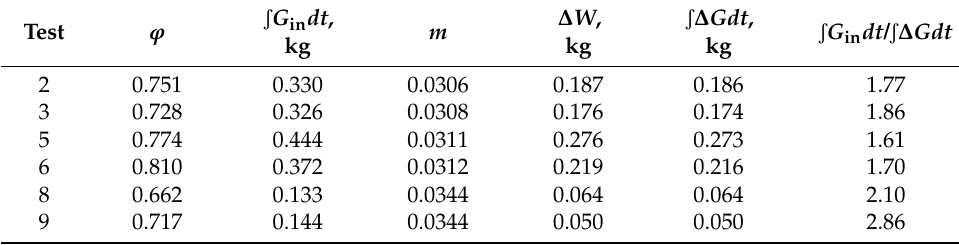
Table 2. Results of tests with